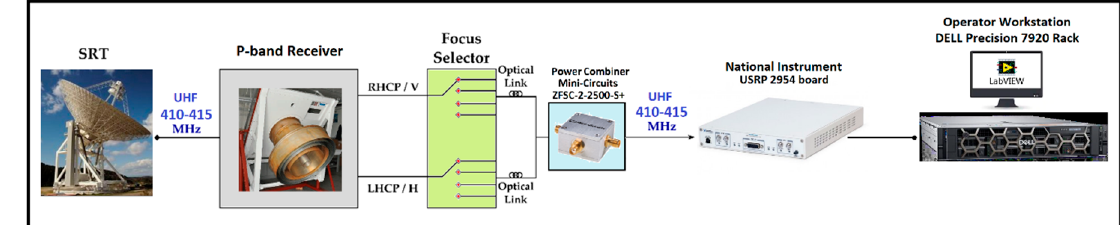
Figure 7. Receiving chain for the National Instrument USRP 2954R board as backend.